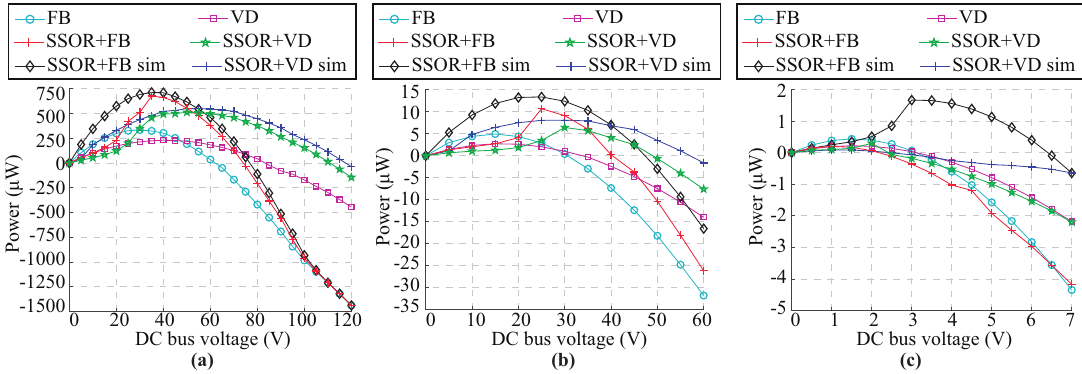
Figure 6. Output power by electric field energy harvesters equipped with different management circuits; ( a ) harvester length: 10 m; ( b ) harvester length: 1 m; ( c ) harvester length: 10 cm.